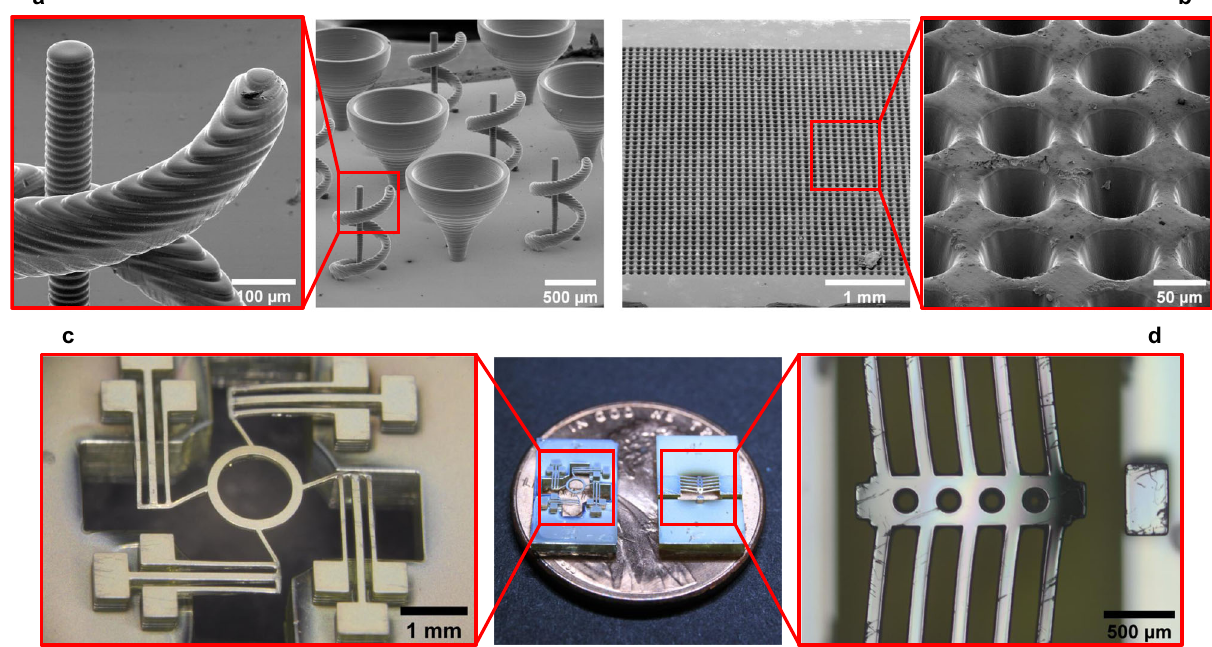
Fig. 4 Variety of 3D microdevices fabricated using a static liquid constrained interface. a Array of helical coils, pillars, and funnels that are 1 mm tall. Such high aspect ratio features do not break during the fabrication process because the dewetting step from the inert liquid does not lead to mechanical separation forces. Furthermore, the 13 μ m per layer thickness shows the ability to achieve high vertical resolution by dye loading in the resin. b Densely packed array of channels (holes) that are 75 μ m in diameter and 1 mm deep. The minimum solid wall width between each channel is ~16 μ m. c A microdevice with a suspended ring tethered to an array of suspended cantilever beams, which are 1.5 mm long and 60 μ m wide. d An electrothermal actuator (MEMS device) that displaces in-plane when heated with electrical current. The actuation of this device is demonstrated in Supplementary Fig. 6 and Supplementary Movie